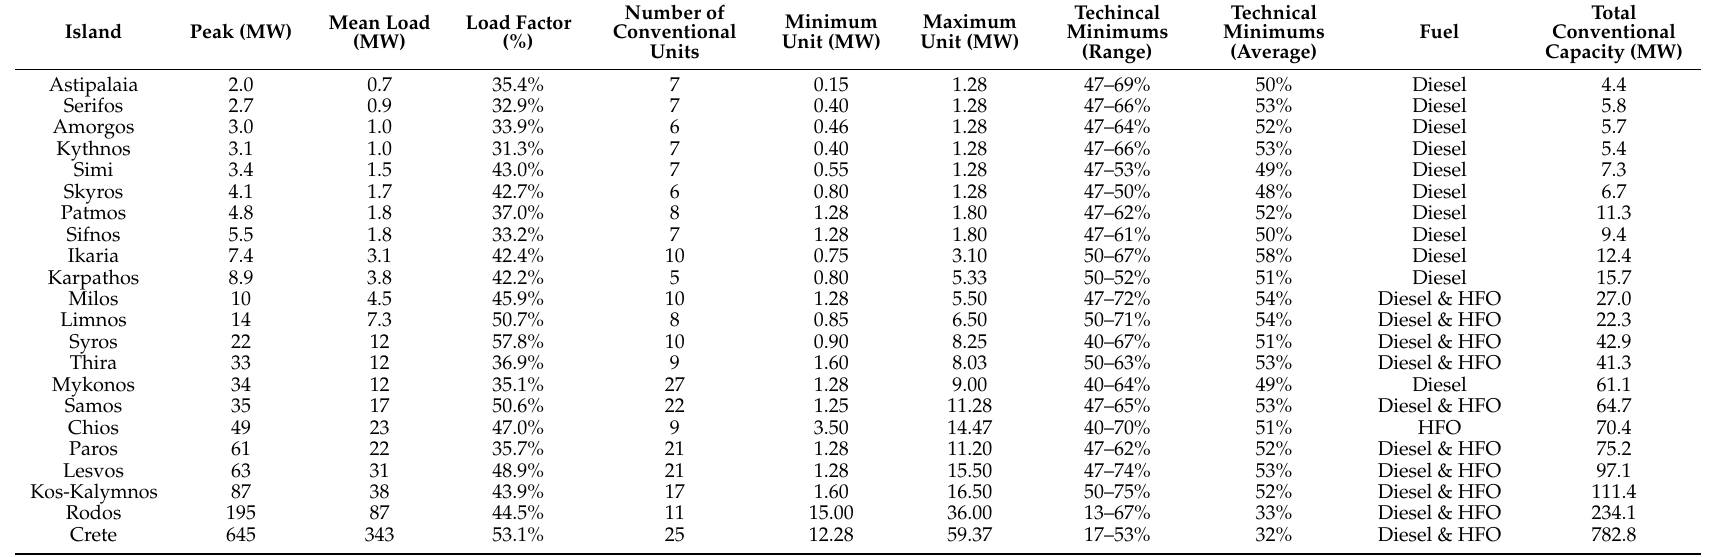
Table 3. Overview of local conventional power stations (data